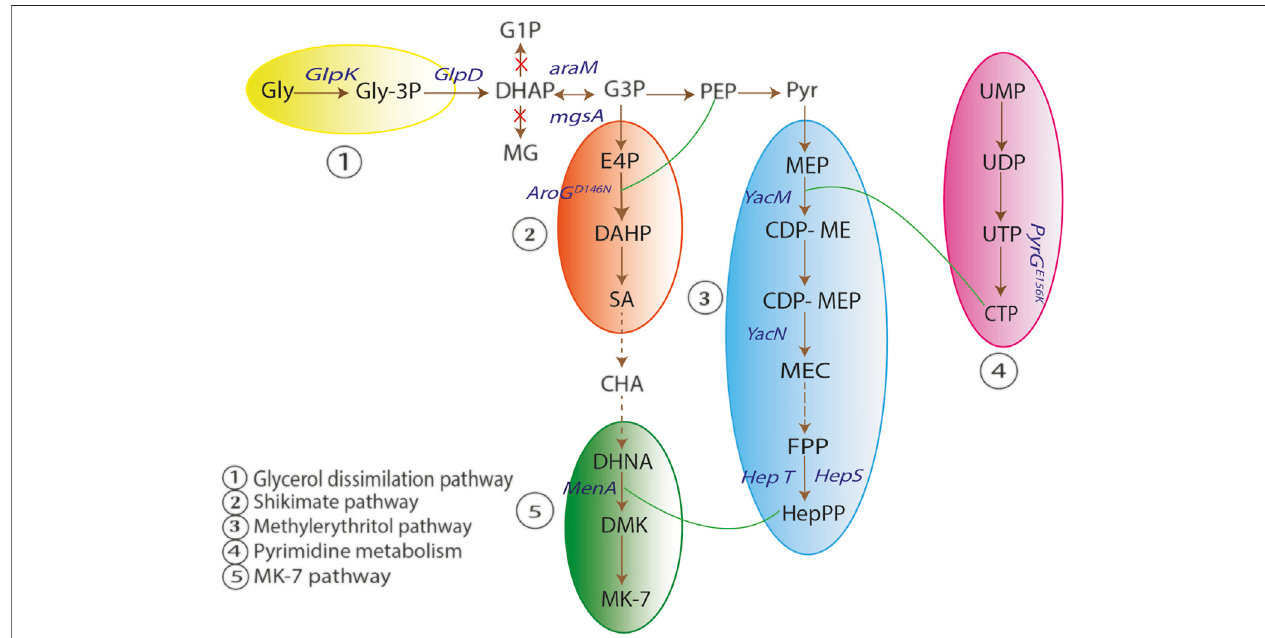
FIGURE 3 | Schematic representation of vitamin K2-7 synthesis. In glycerol dissimilation pathway, overexpression of enzymes glycerol kinase (GlpK) and glycerol- 3-phosphate dehydrogenase (GlpD) leads to conversion of glycerol (Gly) to dihydroxyacetone phosphate (DHAP). Conversion of DHAP to methylglyoxal (MG) and glyceraldehyde-1-phosphate (G1P) is prevented by deleting mgsA and araM. DHAP is interconverted to glyceraldehyde-3-phosphate (G3P) which is converted to pyruvate(Pyr).Pyrentersthemethylerythritolpathway(MEP) inwhichtheend productisheptaprenylpyrophosphate(HepPP).SynthesisofHepPPisenhanced by overexpression of enzyme heptaprenyl diphosphate synthase (HepS). HepPP enters MK-7 pathway to form MK-7 (vitamin K2-7). AroG D146N and PyrG E156K are overexpressed in shikimate (SA) pathway and pyrimidine metabolism pathway respectively to lead the components of both the pathways towards MK-7 pathway and form MK-7 as the end product (Adapted from (Yang et al.,